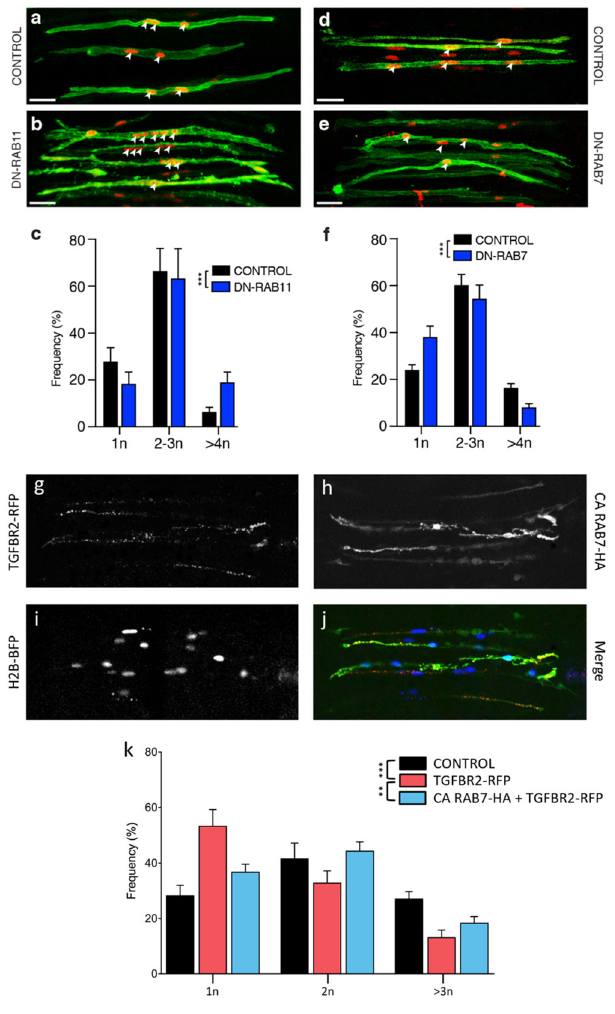
Fig. 5 RAB and TGF β signalling cooperate to regulate fusion. a , b , d , e DML-derived myocytes electroporated with MLC promoter driving expression of dominant negative (DN) variants of RAB11 ( b ) and RAB7 ( e ), together with membrane GFP (green) and nuclear mCherry